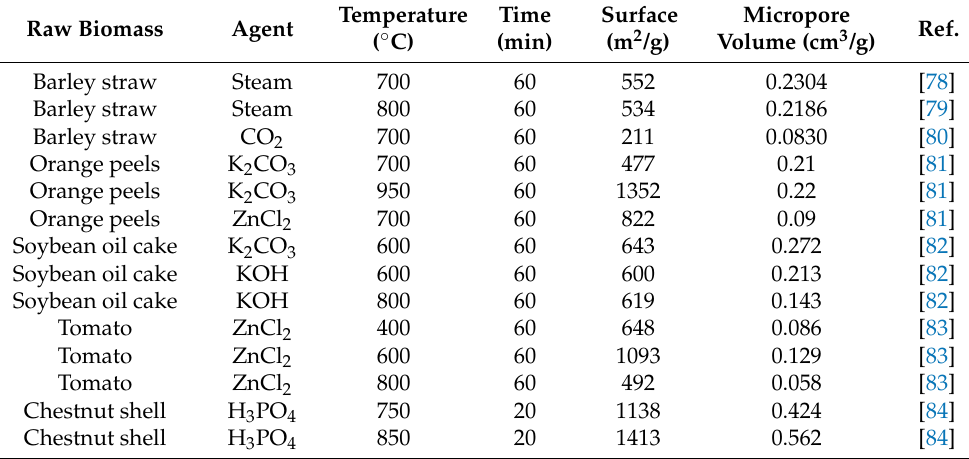
Table 4. The characteristics of activated carbon from pyrolysis with various preparation methods. Raw